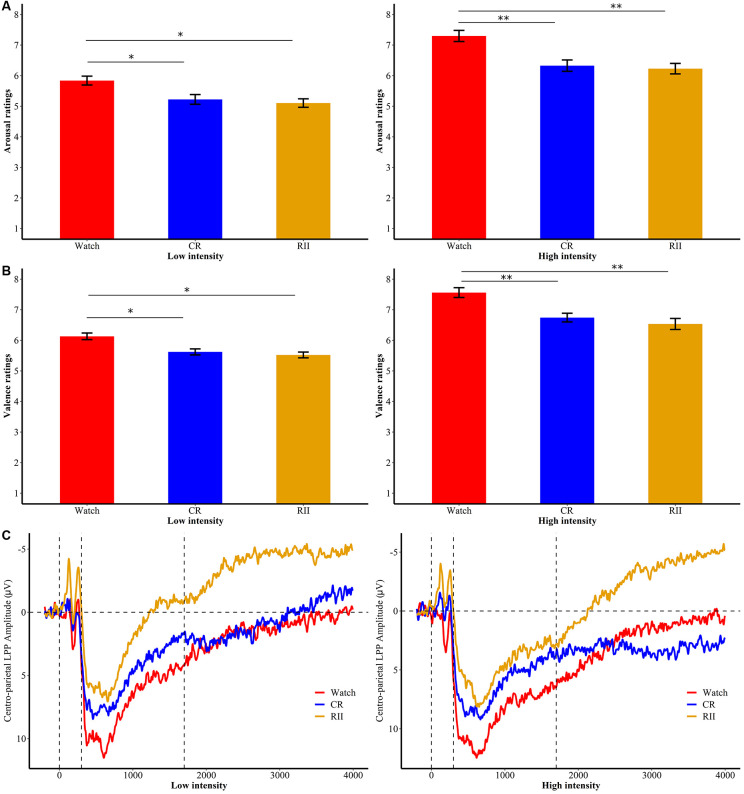
Subjective ratings of emotional (A) arousal and (B) valence for RII, CR, and watch groups in low- and high-intensities of the first exposure. *p < 0.05; **p < 0.001; bars represent standard error. RII, reappraisal by implementation intention; CR, controlled reappraisal. (C) Centro-parietal LPP amplitudes for RII, CR, and watch groups in high and low emotional intensities of the first exposure. Waveforms are averaged across CPz and Pz electrodes. The x-axis runs from the beginning of the baseline (−200 ms before picture onset) to the end of the picture presentation (4,000 ms).